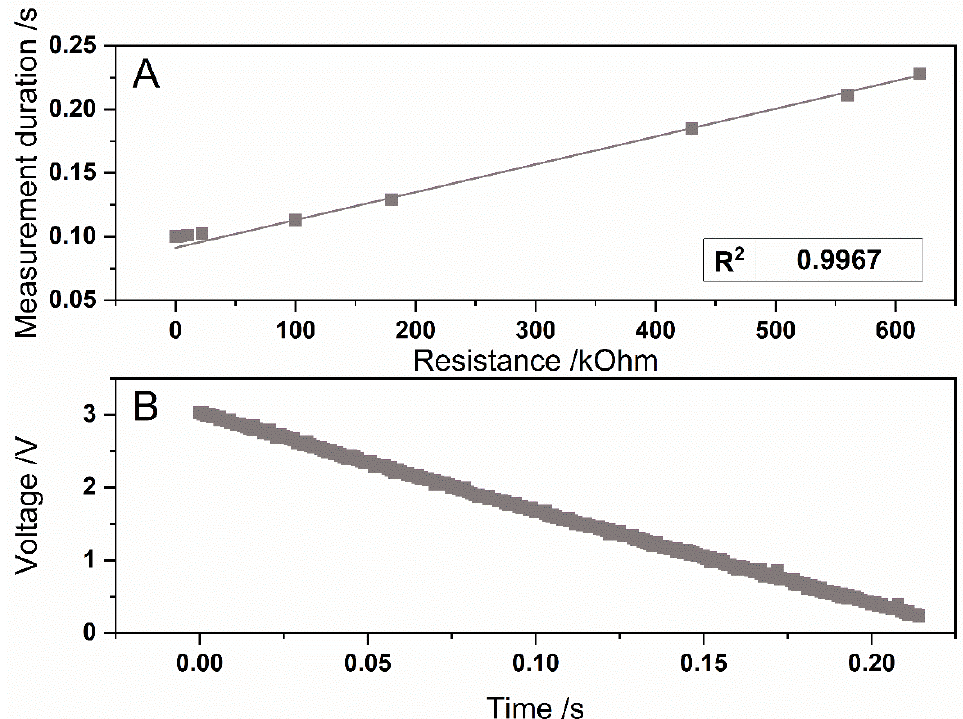
Figure 4. Measurement duration of the Portuino with a circuit, based on the discharge of a capacitor. The phototransistor was illuminated with a white light LED, which was connected with different series resistors with values from 0.1 to 600 kΩ. ( A ). The discharge of the capacitor was measured with an oscilloscope. The phototransistor was illuminated with the LED with a forward resistor of 560 kΩ ( B ). n = 3, and the error bars are hidden by the squares.